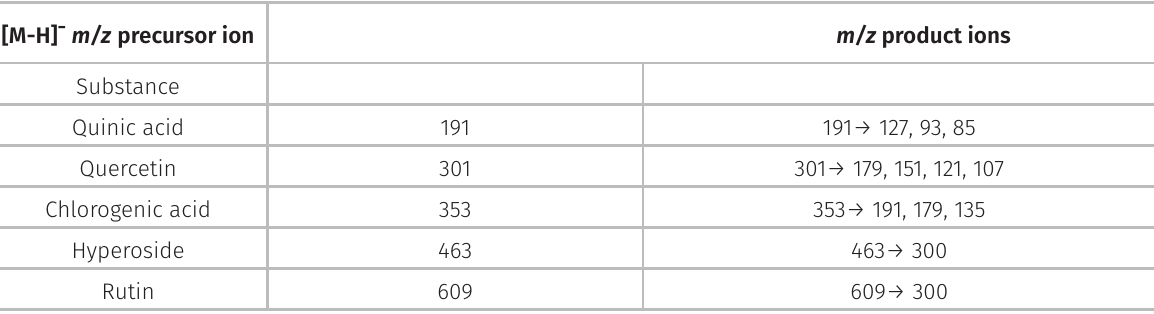
Table I. Identified substances in the ethanolic extract of S. microglossa flowers by comparison of the ESI(-)-MS/MS spectrum with the database www.massbank.eu.